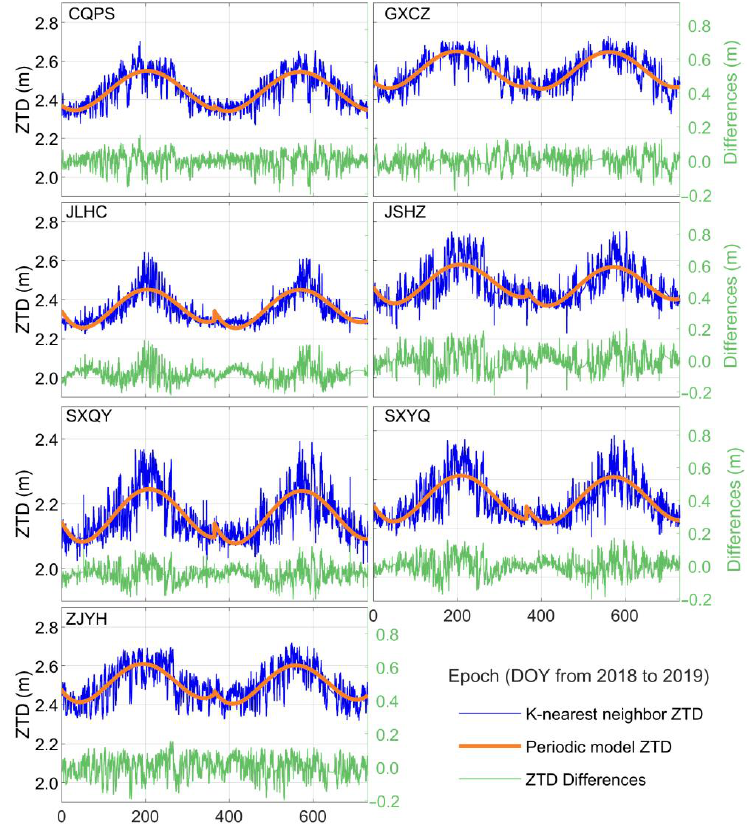
Figure 6. Comparison between the KNN and the periodic model. N = 730, the blue and orange curves show the KNN and periodic model derived ZTDs, respectively. The green curve shows ZTD series differences between the two models.